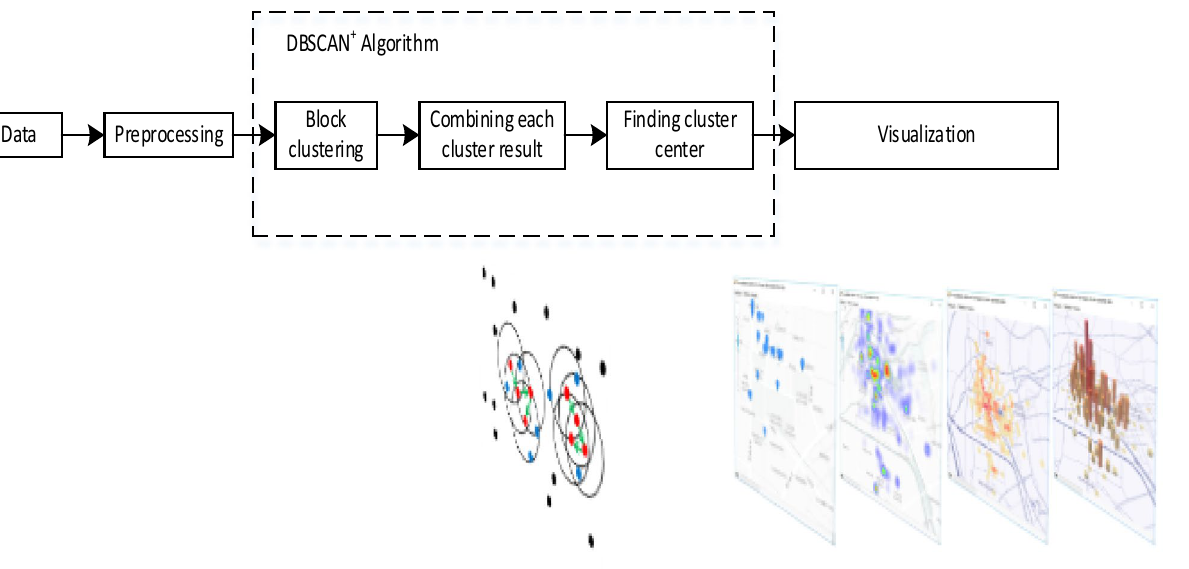
Figure 1. The flow chart of the